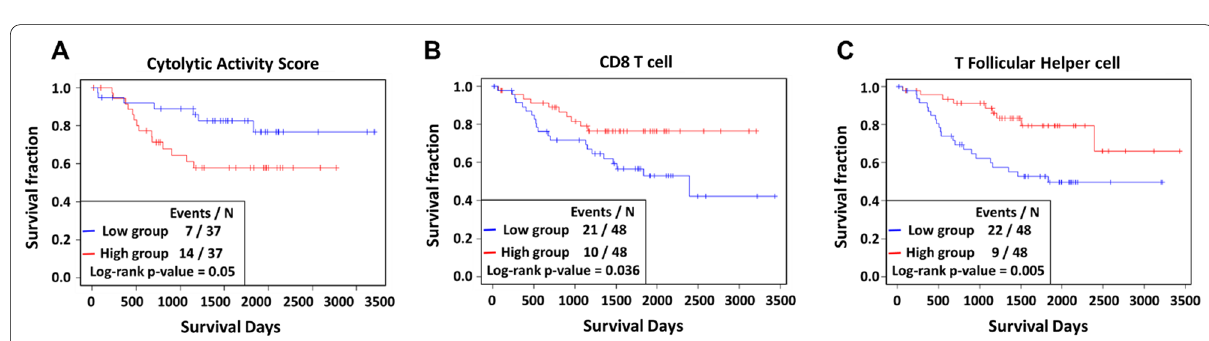
Fig. 7 Prognostic value of immune cell scores. Kaplan–Meier curves of each A cytolytic activity score, B CD8 T cell, and C T follicular helper cell group divided by the median values of the parameters for overall survival. Red, high group; blue, low group. The boxes in each survival curve show a number of dead and the total number of patients for groups and the p values according to by log‑rank